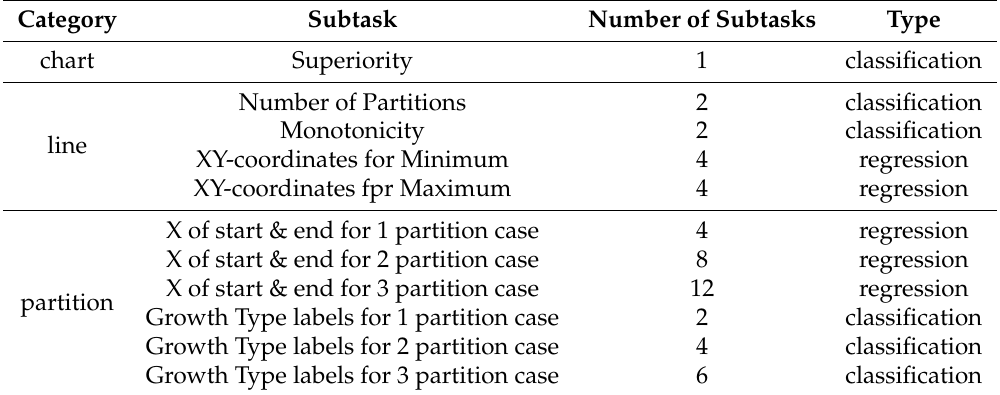
Table 2. Numbers and types of subtasks (the number of output variables to predict is doubled for two lines in all subtasks except superiority).